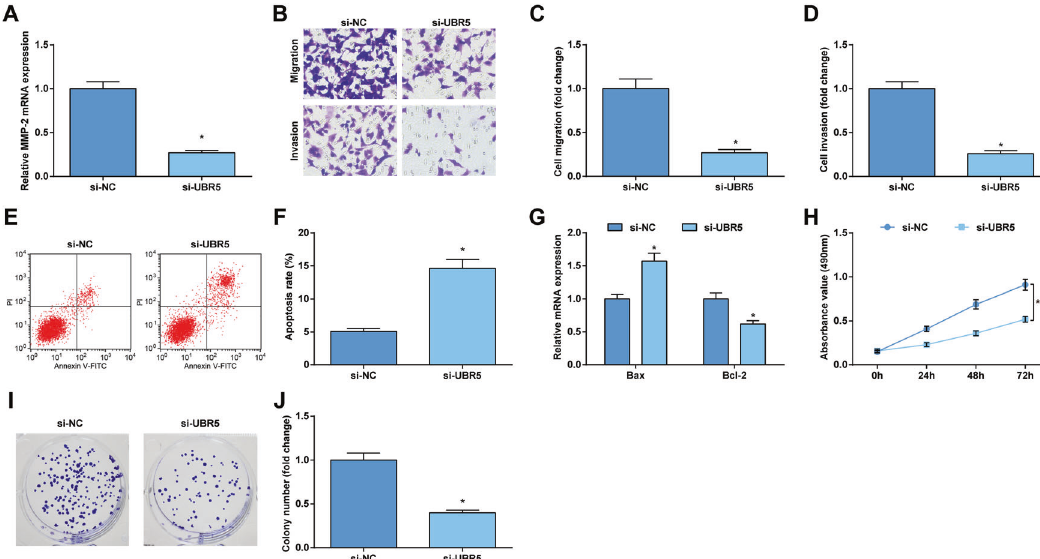
Fig. 6 Suppression of UBR5 retards U87 cell growth. A RT-qPCR tested MMP-2 mRNA expression in U87 cells. B – D Transwell assay tested the migration and invasion of U87 cells. E , F Flow cytometry tested apoptosis of U87 cells. G RT-qPCR tested Bcl-2 and Bax mRNA expression in U87 cells. H MTT tested the optical density of U87 cells at 490 nm (0, 24, 48, and 72 h). I , J Colony formation assay tested the colony-forming ability of U87 cells. The data were all measurement data, in the form of mean ± standard deviation; * P < 0.05 compared with the si-NC group.